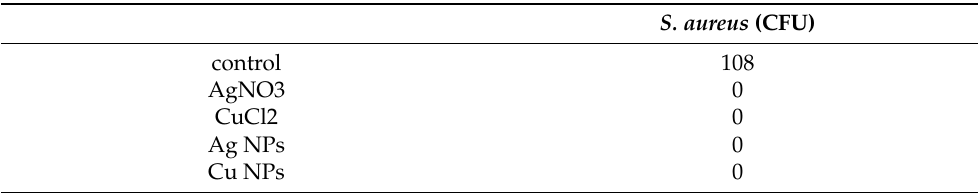
Table 4. Number of S. aureus CFU after treatment with Ag, Cu NPs, AgNO 3 and CuCl 2 solutions with different concentrations. Data in the table represent the results for all used